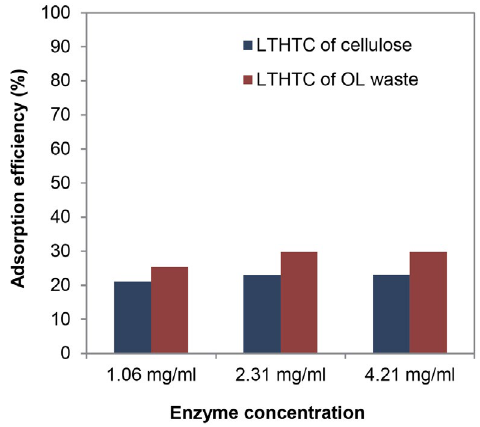
Figure 1. Influence of enzyme concentration on adsorption efficien- cy of biochar from two different sources (LTHTC of OL waste or LTHTC of cellulose). Reaction conditions: 5 mg of chosen biochar, PBS with pH 7, 24-h adsorption with continuous stirring at 300 rpm, at ambient temperature and at atm. pressure. Standard devia- tion for all measurements was less than ±